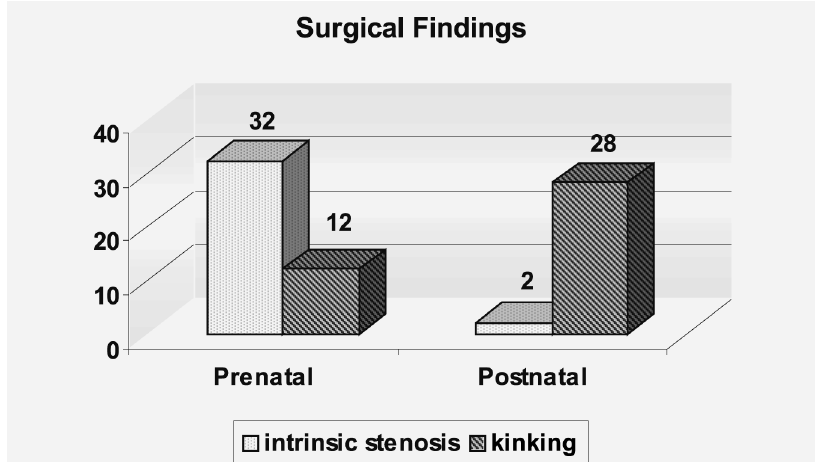
Figure 1 – Comparison of frequencies of intrinsic stenosis and ureteral kinking in patients with prenatally and postnatally diagnosed ureteropelvic junction obstruction (p < 0.01 for both